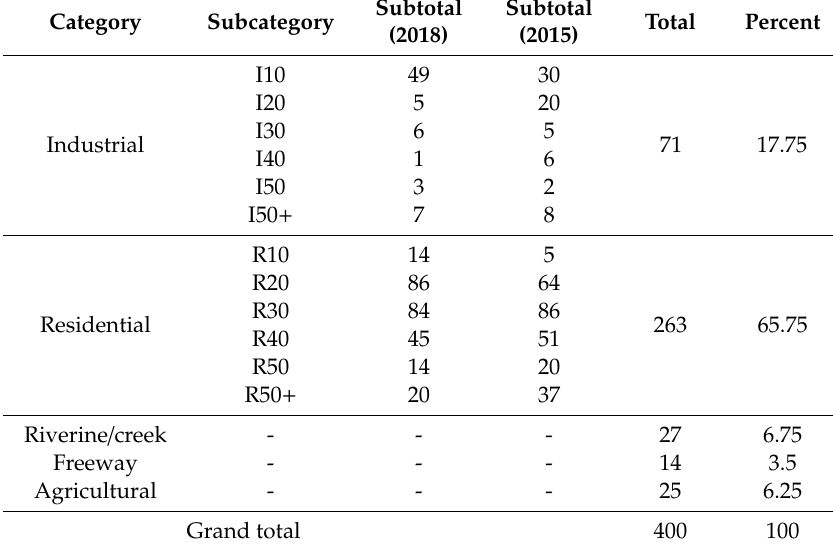
Figure 3. ( a ) Indices-based LULC map showing the spatial distribution of the three LULC classes (2018), where the built-up is located in the core surrounded by the green at the fringes, and the major water portion is the river that passes across diagonally from southwest to northeast in the middle; and ( b ) the LST map (2018) representing the temperature variations over the study area, where the higher LST are located in the built-up, and the lower LST are along the green and water classes. Table 7. Number of neighbourhoods in different categories and subcategories.